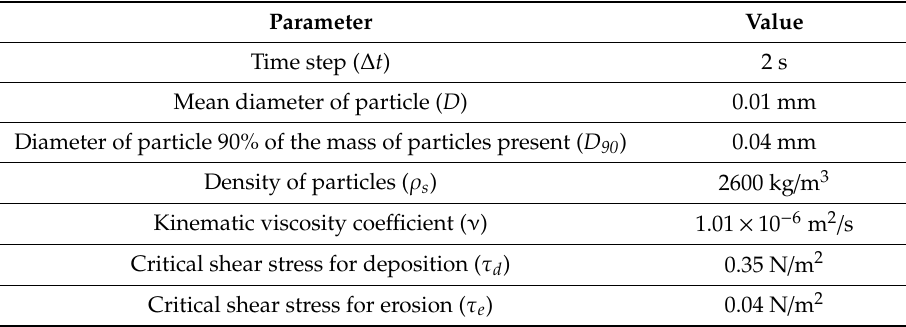
Table 2. Model parameters.